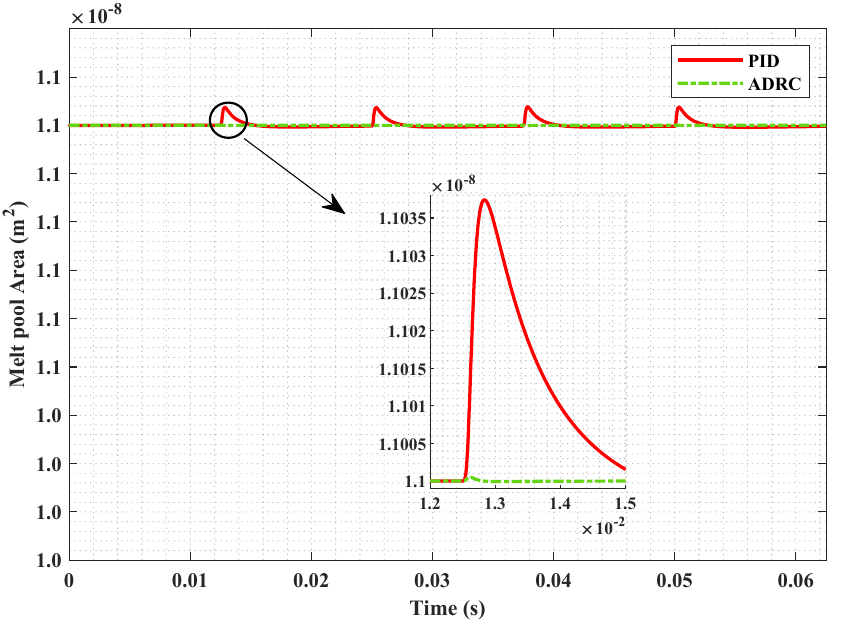
Figure 7. Melt pool area tracking by PID and LADRC controller. Table 4. Comparison of PID and LADRC controllers.